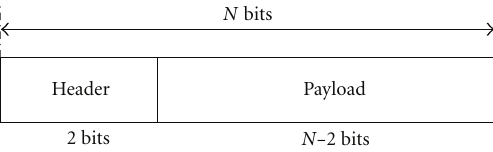
Figure 19: Streaming packet